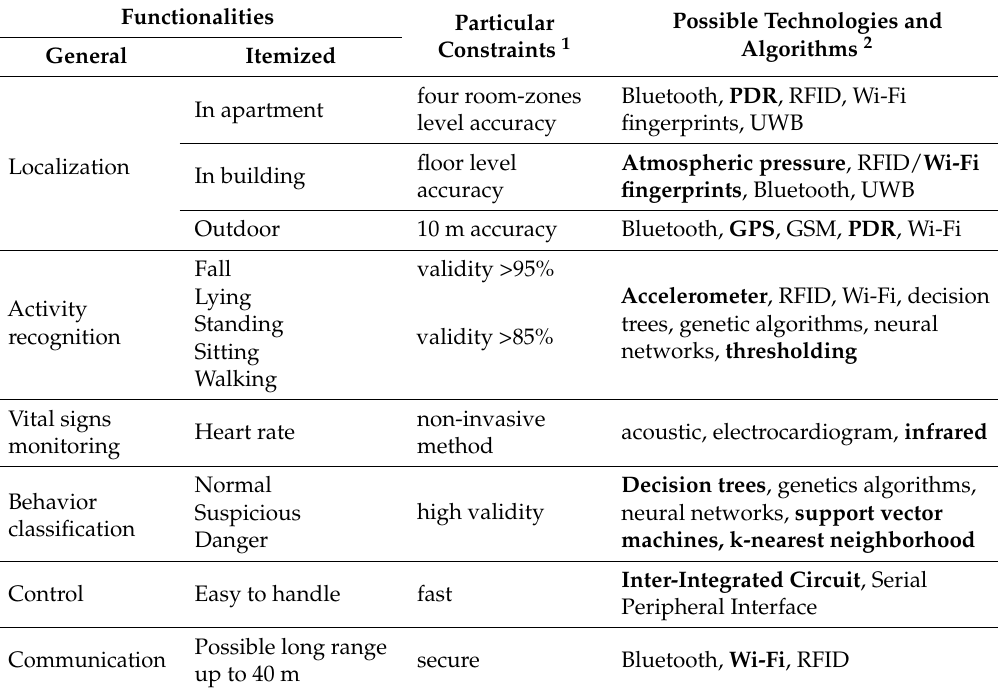
Table 1. Technologies and algorithms related to itemized functionalities and particular